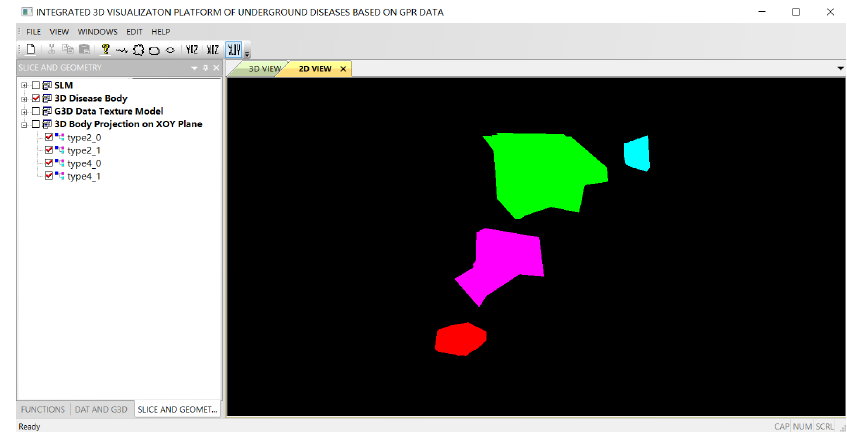
Figure 14. The projection of 3D geohazard bodies.